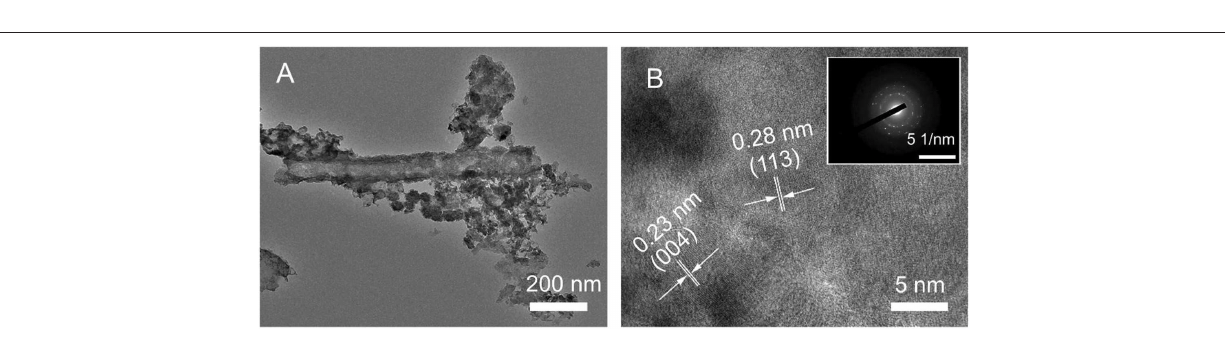
Figure 4B is a CuCo 2 S 4 /CC and CuCo 2 S 4 GCD curves at